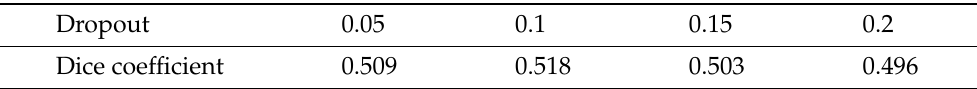
Table 2. First block dropout and corresponding Dice coefficient score (these scores were before the post-processing